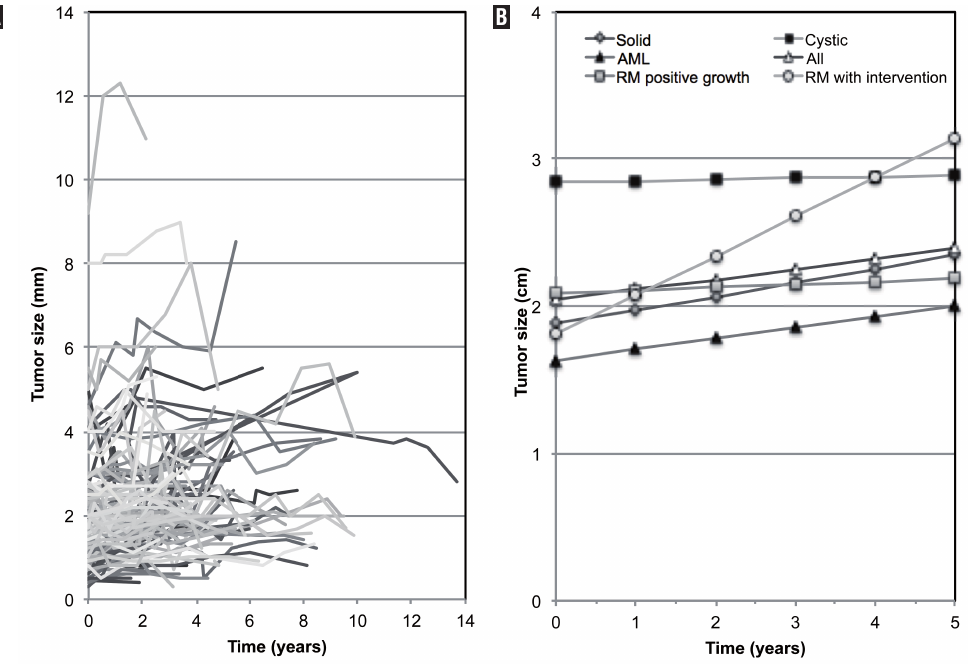
figure 2 - A: Time dependent changes in maximal renal mass diameter for all renal masses. B: Time dependent changes in maximal renal mass diameter stratified by tumor type.